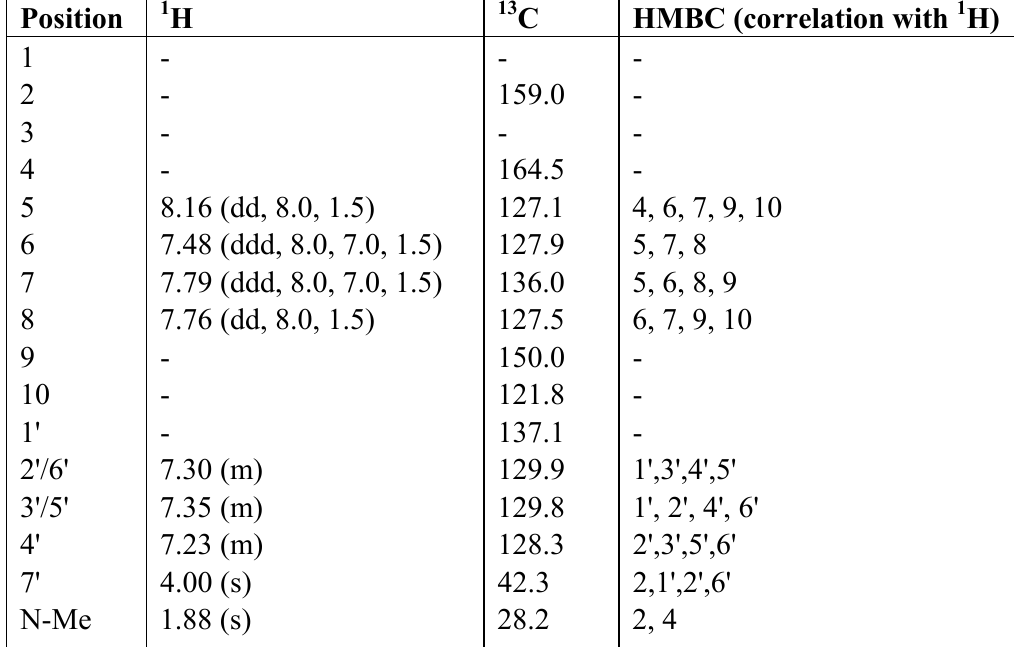
Table 1. 1 H- (500 MHz) and 13 C-NMR (125 MHz) data of 1 (CD ppm) and HMBC correlations.